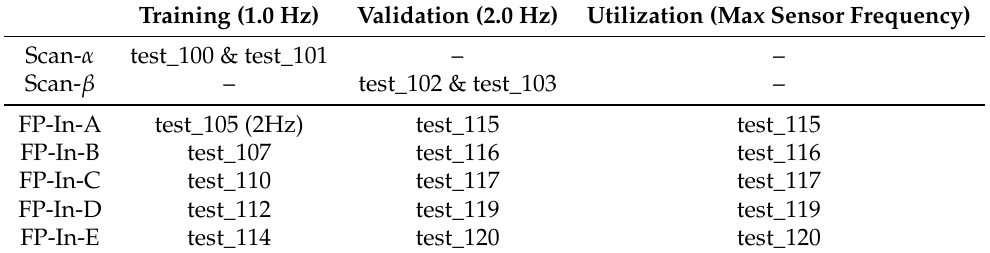
Table 3. The indoor flight profiles from Section 4.3 have dedicated flight trajectories for GPR training and validation. The indoor experimental profiles match the outdoor versions, but with smaller footprints to fit in the spatially constrained indoor motion capture